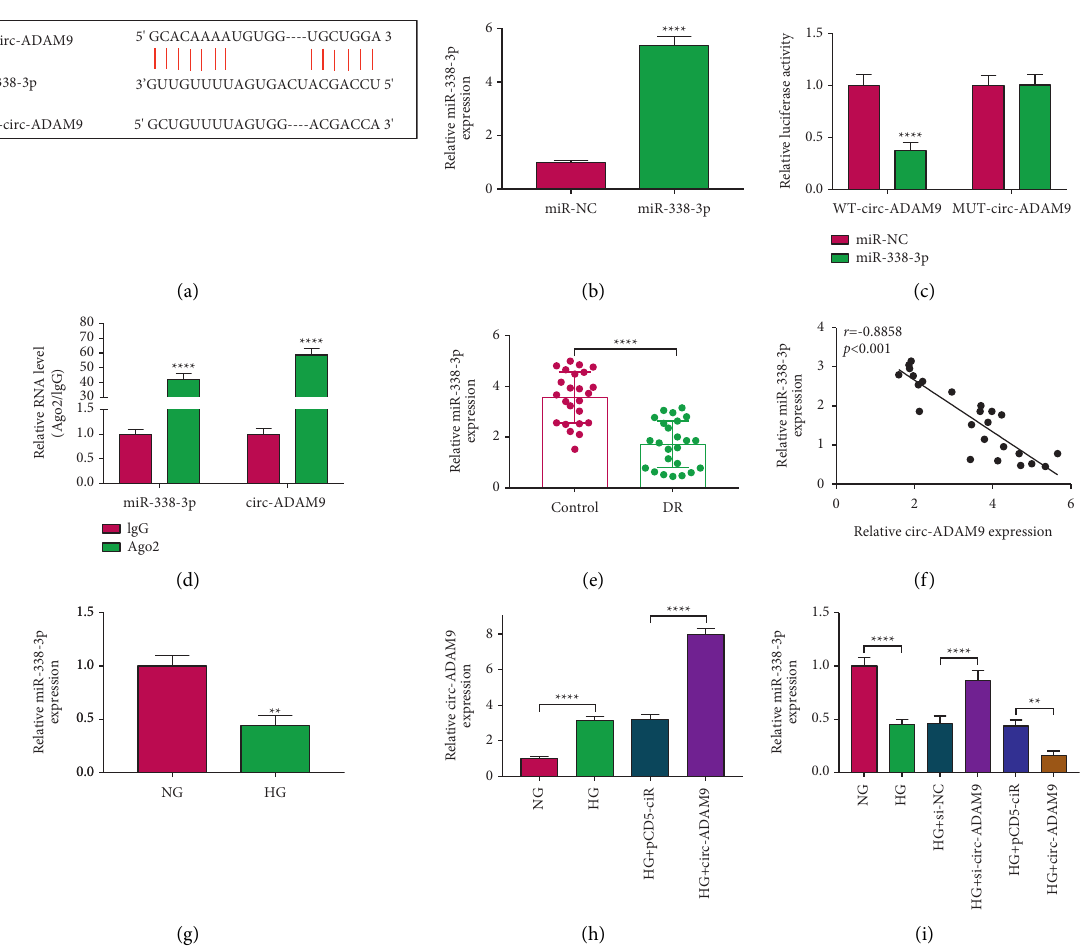
Figure 3: Circ-ADAM9 sponged miR-338-3p. (a) The binding sites between circ-ADAM9 and miR-338-3p were shown. (b) miR-338-3p expression was detected by qRT-PCR to assess the transfection efficiency of miR-338-3p mimic. The interaction between circ-ADAM9 and miR-338-3p was verified by dual-luciferase reporter assay (c) and RIP assay (d). (e) The miR-338-3p expression in the serum of DR patients and normal control volunteers was detected by qRT-PCR. (f) Pearson’s correlation coefficient analysis was used to analyze the correlation between circ-ADAM9 and miR-338-3p. (g) QRT-PCR was performed to examine miR-338-3p expression in ARPE-19 cells under HG and NG conditions. (h) Circ-ADAM9 expression was measured by qRT-PCR to evaluate the transfection efficiency of pCD5 circ-ADAM9 overexpression vector. (i) miR-338-3p expression was detected by qRT-PCR in HG-induced ARPE-19 cells transfected with si-circ-ADAM9 or pCD5 circ-ADAM9 overexpression vector. ∗∗ P < 0 . 01 and ∗∗∗∗ P < 0 .